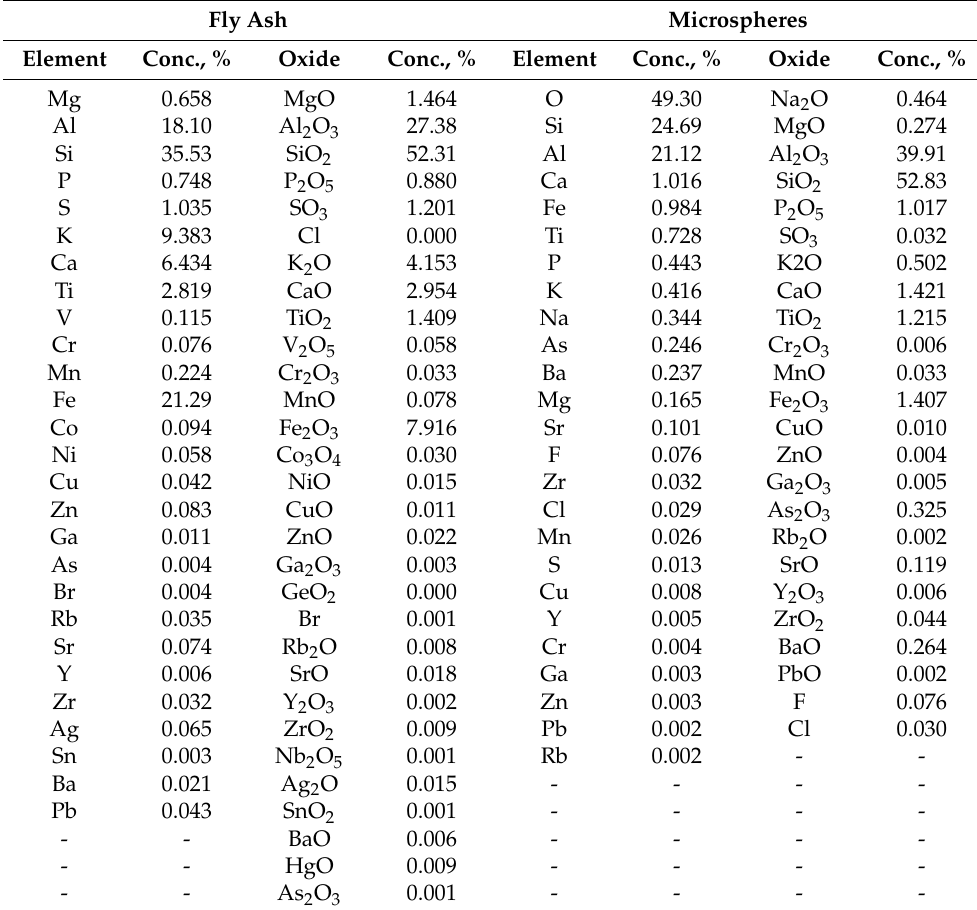
Table 1. Chemical composition of flay ash and